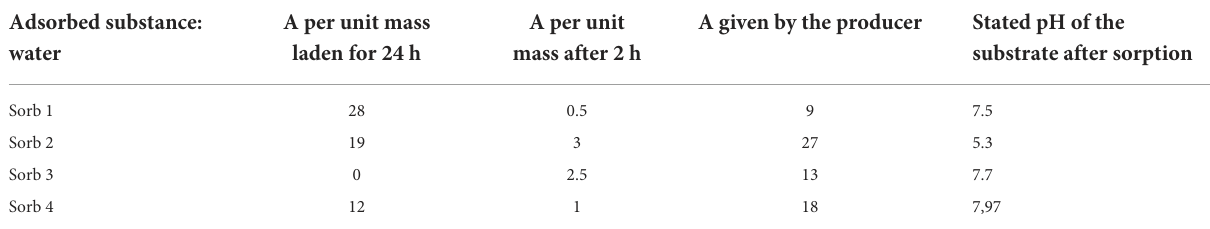
TABLE 3 Comparison of experimentally acquired values of the adsorption capacity = adsorbent performance (capacity testing) (A) after 24h of sorption and after 2h of sorption on the water sample. Adsorbed